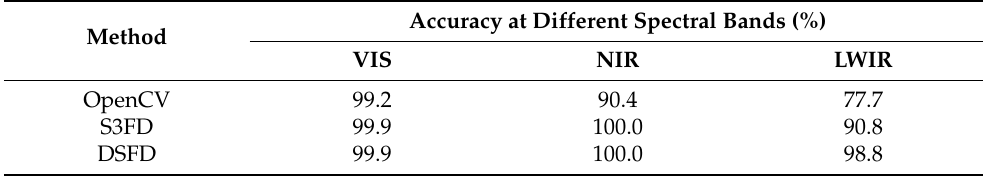
Table 1. Accuracy of the different face detection algorithms in the TUFTS database.